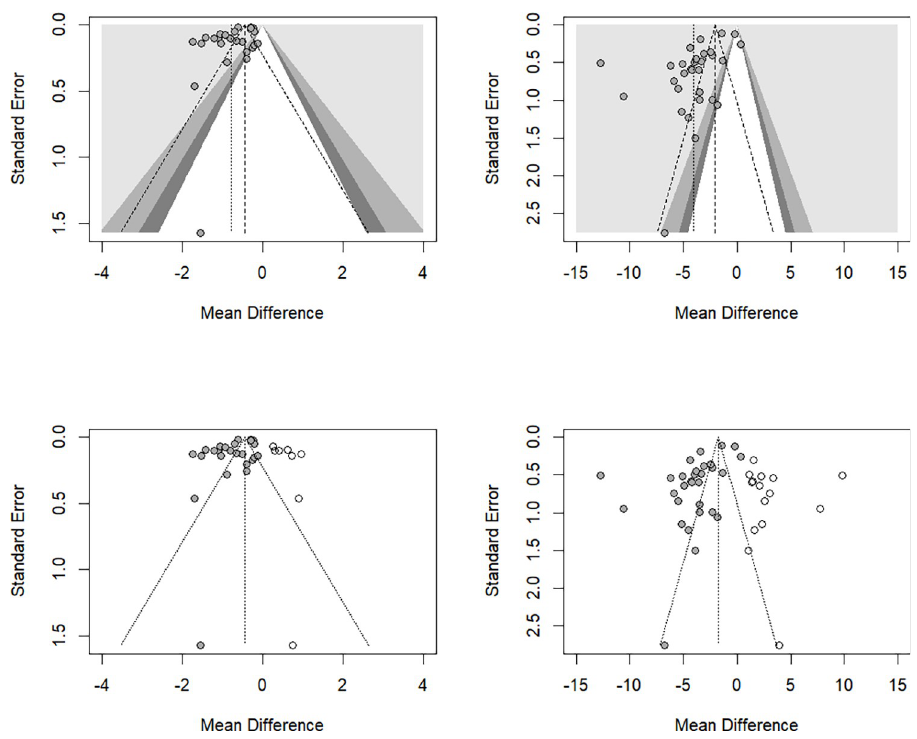
Fig 2. Contour-enhanced and filled funnel plots of glycated hemoglobin level and body weight. (upper left) Contour-enhanced funnel plot of the pooled glycated hemoglobin level after treatment with a glucagon-like peptide-1 receptor agonist. (lower left) Filled funnel plot of the pooled glycated hemoglobin level after treatment with a glucagon-like peptide-1 receptor agonist. (upper right) Contour-enhanced funnel plot of the pooled body weight after treatment with a glucagon-like peptide-1 receptor agonist. (lower right) Filled funnel plot of the pooled body weight after treatment with a glucagon-like peptide-1 receptor agonist.